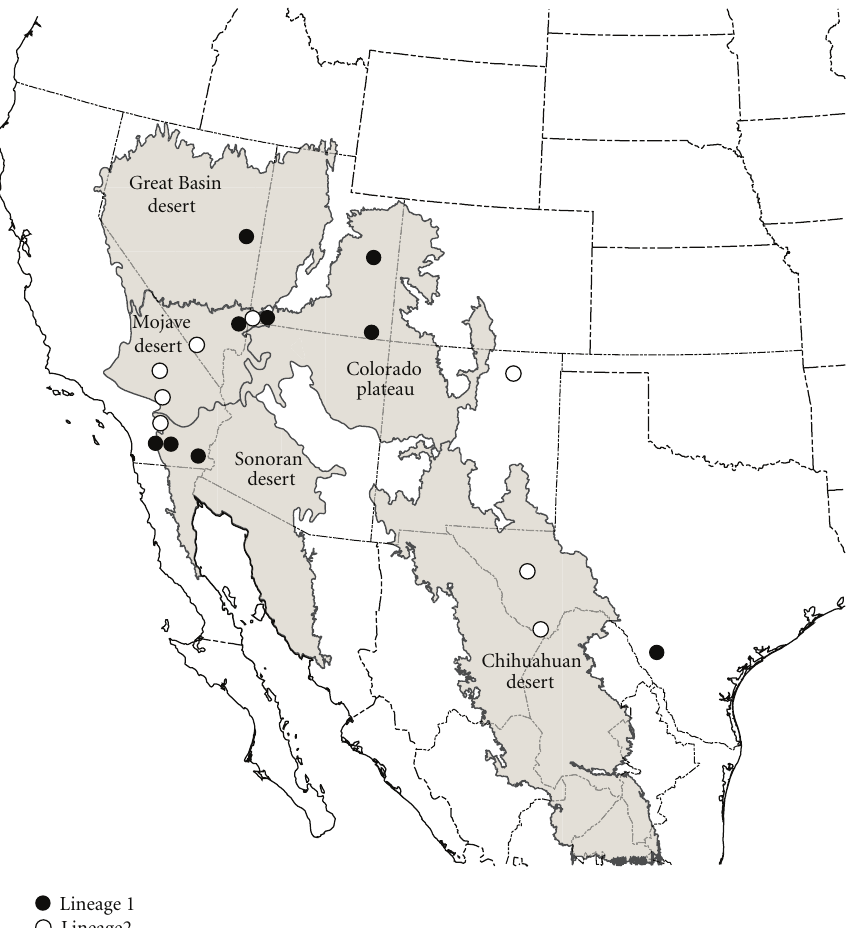
Figure 2: Map of Western North America showing the major deserts and arid lands altered from Omernik [22]. Closed circles ( (cid:2) ) indicate collection locations of specimens from lineage 1, and open circles ( (cid:3) ) indicate collection locations of specimens from lineage